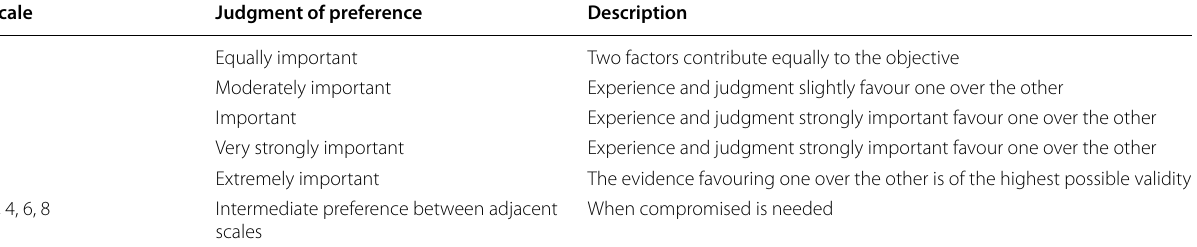
Table 3 The fundamental scale of various compared elements